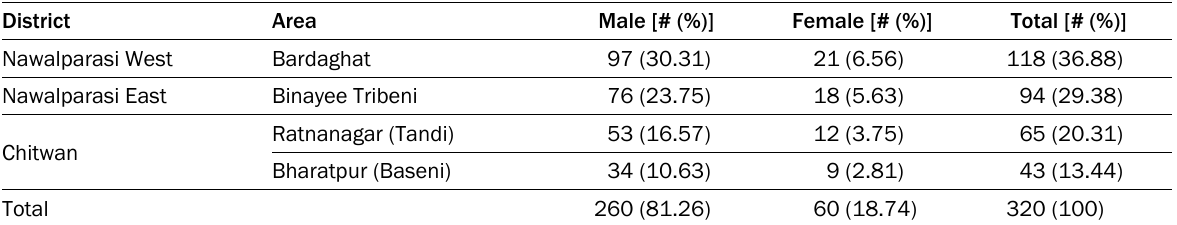
Table 1. Sample Distribution in the Study Area